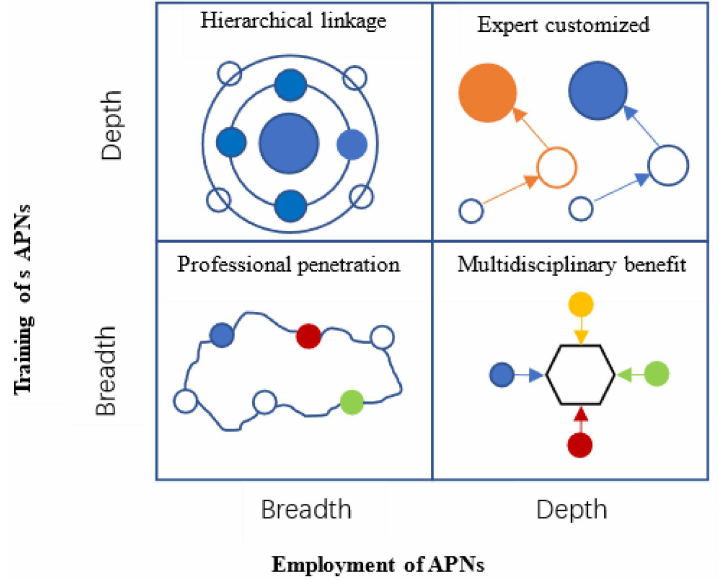
Figure 1. Management strategies of APNs. In the diagram, solid circles indicate APNs, while hollow circles represent general nurses. The size of the circle denotes the amount of training, and the color of the circle symbolizes the various specializations. The hollow hexagon depicts a distinct group of patients who are the attention of APNs. Table 3. Typical examples cited in the case analysis of the four strategy types of